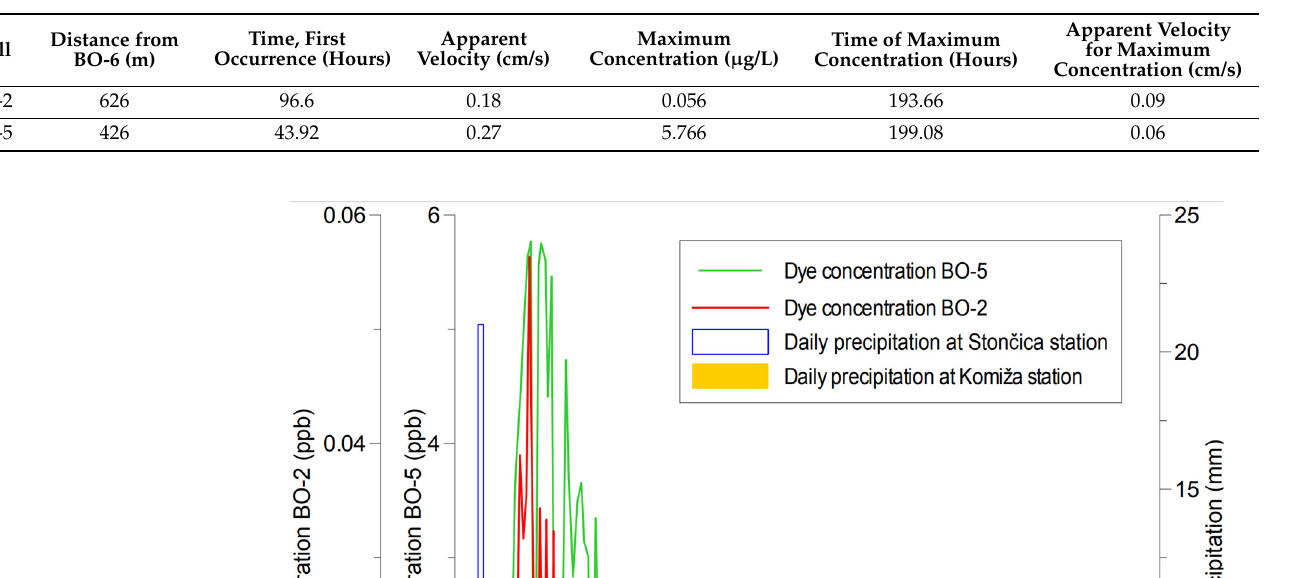
Table 2. Main Parameters Related to Dye Occurrence in Two Wells in Korita.